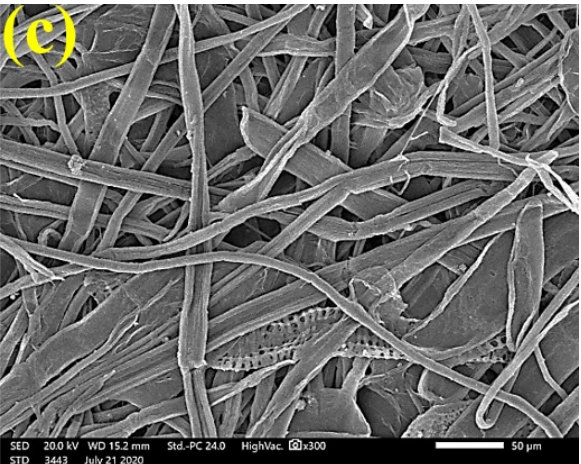
Figure 5. SEM images of the paper sheets manufactured from ( a ) Ficus altissima , ( b ) Sorghum bicolor treated with 0.5% MAHE, and ( c ) Ficus elastica treated with 1% MAHE and inoculated with F. culmorum . Arrows refer to low growth of fungal mycelia based on the concentration of the extract and the type of paper sheet pulp.